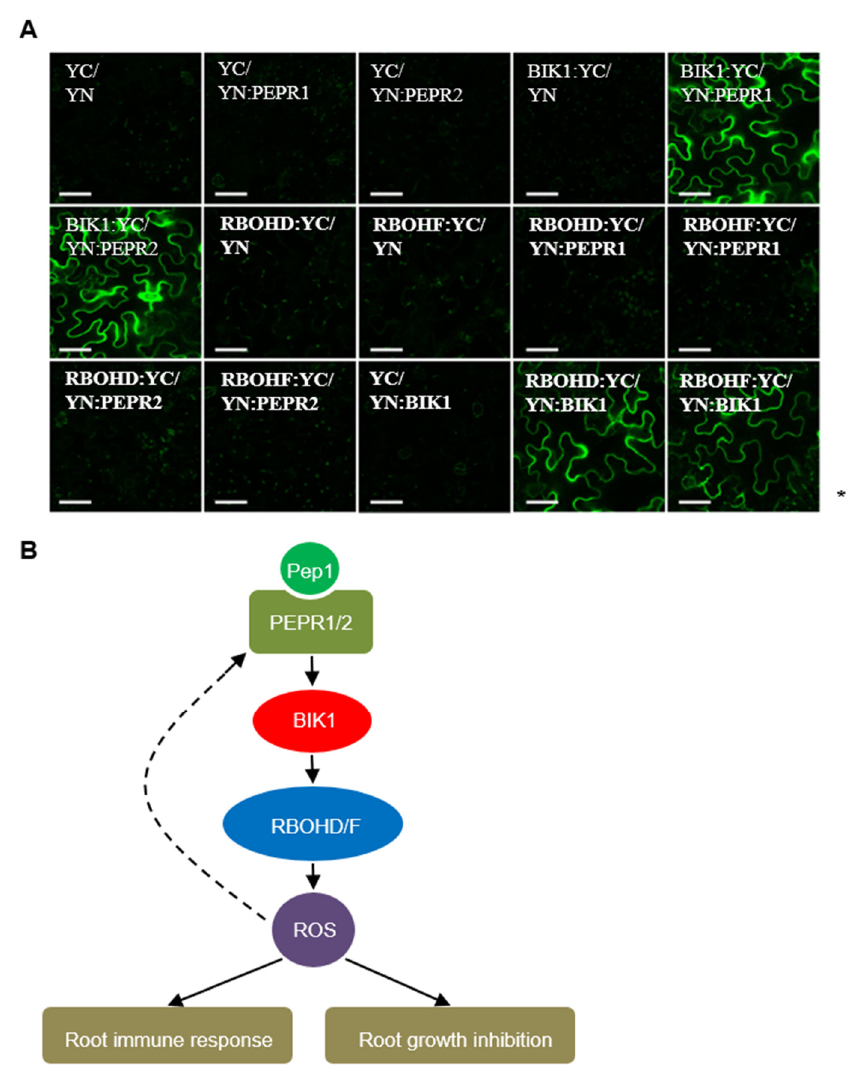
Figure 6. BIK1 interacts with PEPR1 / 2 and RBOHD / F. ( A ) Bimolecular fluorescence complementation of YC / YN, YC / YN:PEPR1, YC / YN:PEPR2, BIK1:YC / YN, BIK1:YC / YN:PEPR1, BIK1:YC / YN:PEPR2, RBOHD:YC / YN, RBOHF:YC / YN, RBOHD:YC / YN:PEPR1, RBOHF:YC / YN:PEPR1, RBOHD:YC / YN:PEPR2, RBOHF:YC / YN:PEPR2, YC / YN:BIK1, RBOHD:YC / YN:BIK1 and RBOHF:YC / YN:BIK1. Images were taken using confocal laser scanning microscopy. Bars = 50 µ m. ( B ) A